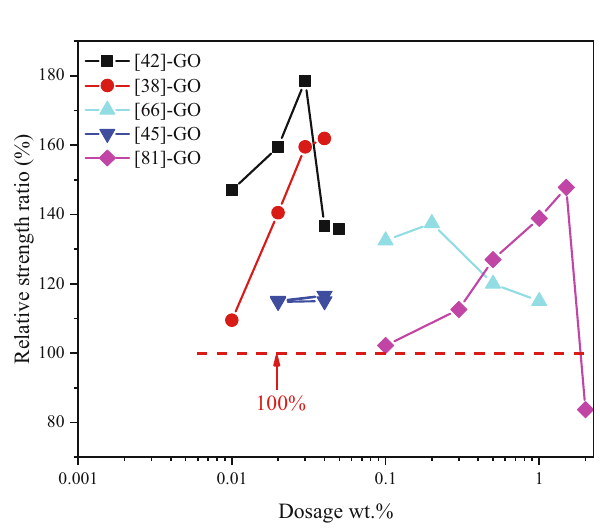
Figure 4: The GO dosages and the tensile strength e ff